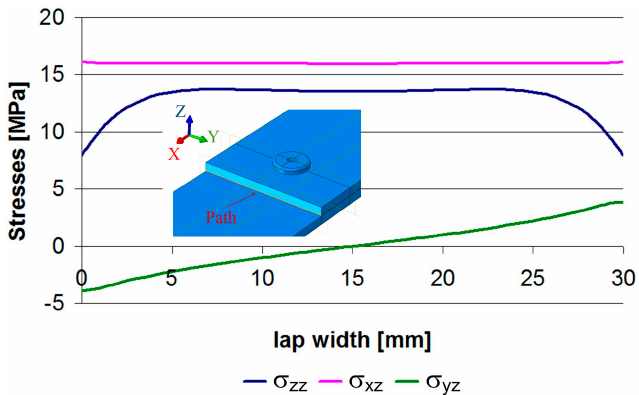
Figure 3. Stresses along the lap width.